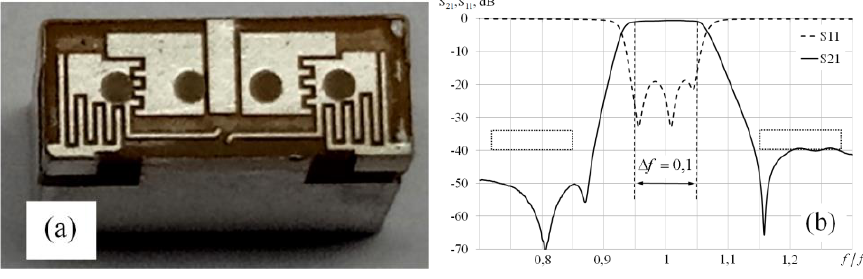
Fig. 9. Proposed QEF on MCB with novel topology (a), measured scattering parameters